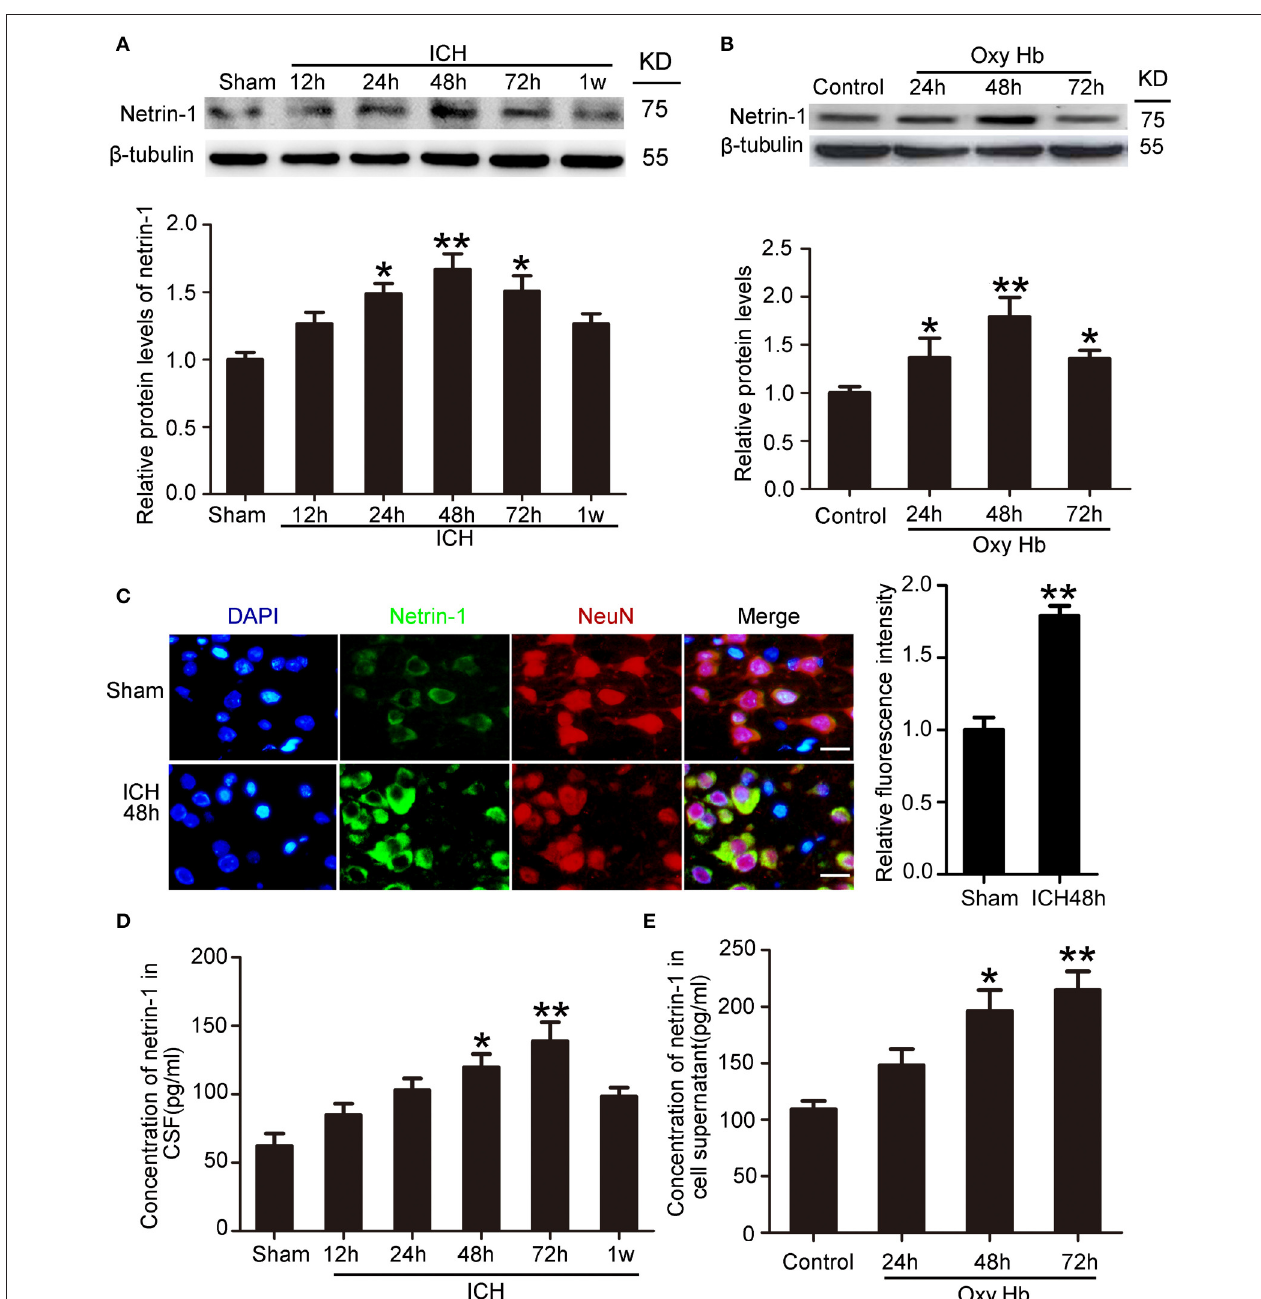
FIGURE 2 | Changes in protein levels and secretion of netrin-1 after ICH. (A) Western blot analysis of netrin-1 in the peri-hematoma cortex at different time points after ICH. All values are expressed as mean ± SEM. Mean values of protein levels in the sham group were normalized to 1.0. * p < 0.05, ** p < 0.01 vs. the sham group, n = 6. (B) Western blot of netrin-1 in cultured neurons exposed to OxyHb. All values are expressed as mean ± SEM. Mean values of protein levels in the control group were normalized to 1.0. * p < 0.05, ** p < 0.01 vs. the control group, n = 3. (C) Double immunofluorescence staining was performed in the peri-hematoma cortex with netrin-1 antibody (green) and a neuronal marker (NeuN, red), and nuclei were labeled with DAPI (blue). Scale bar = 20 µ m, ** p < 0.01 vs. the sham group, n = 6. (D,E) Concentrations of netrin-1 in CSF and cell supernatants were measured by ELISA. * p < 0.05 and ** p < 0.01 vs. the sham group or control group ( D , n = 6; E , n =